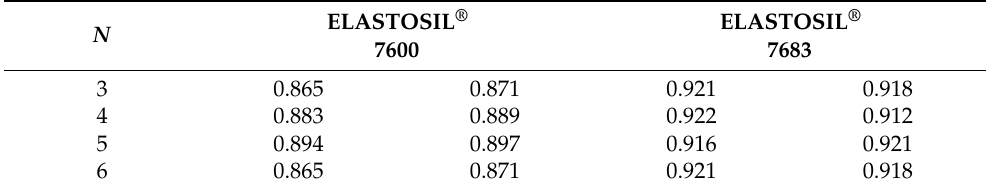
Table 6. Summary results of coefficient of determination (R 2 ) for Ogden–Roxburgh model using Ansys (right) and Abaqus (left) solvers and Nelder–Mead algorithm.